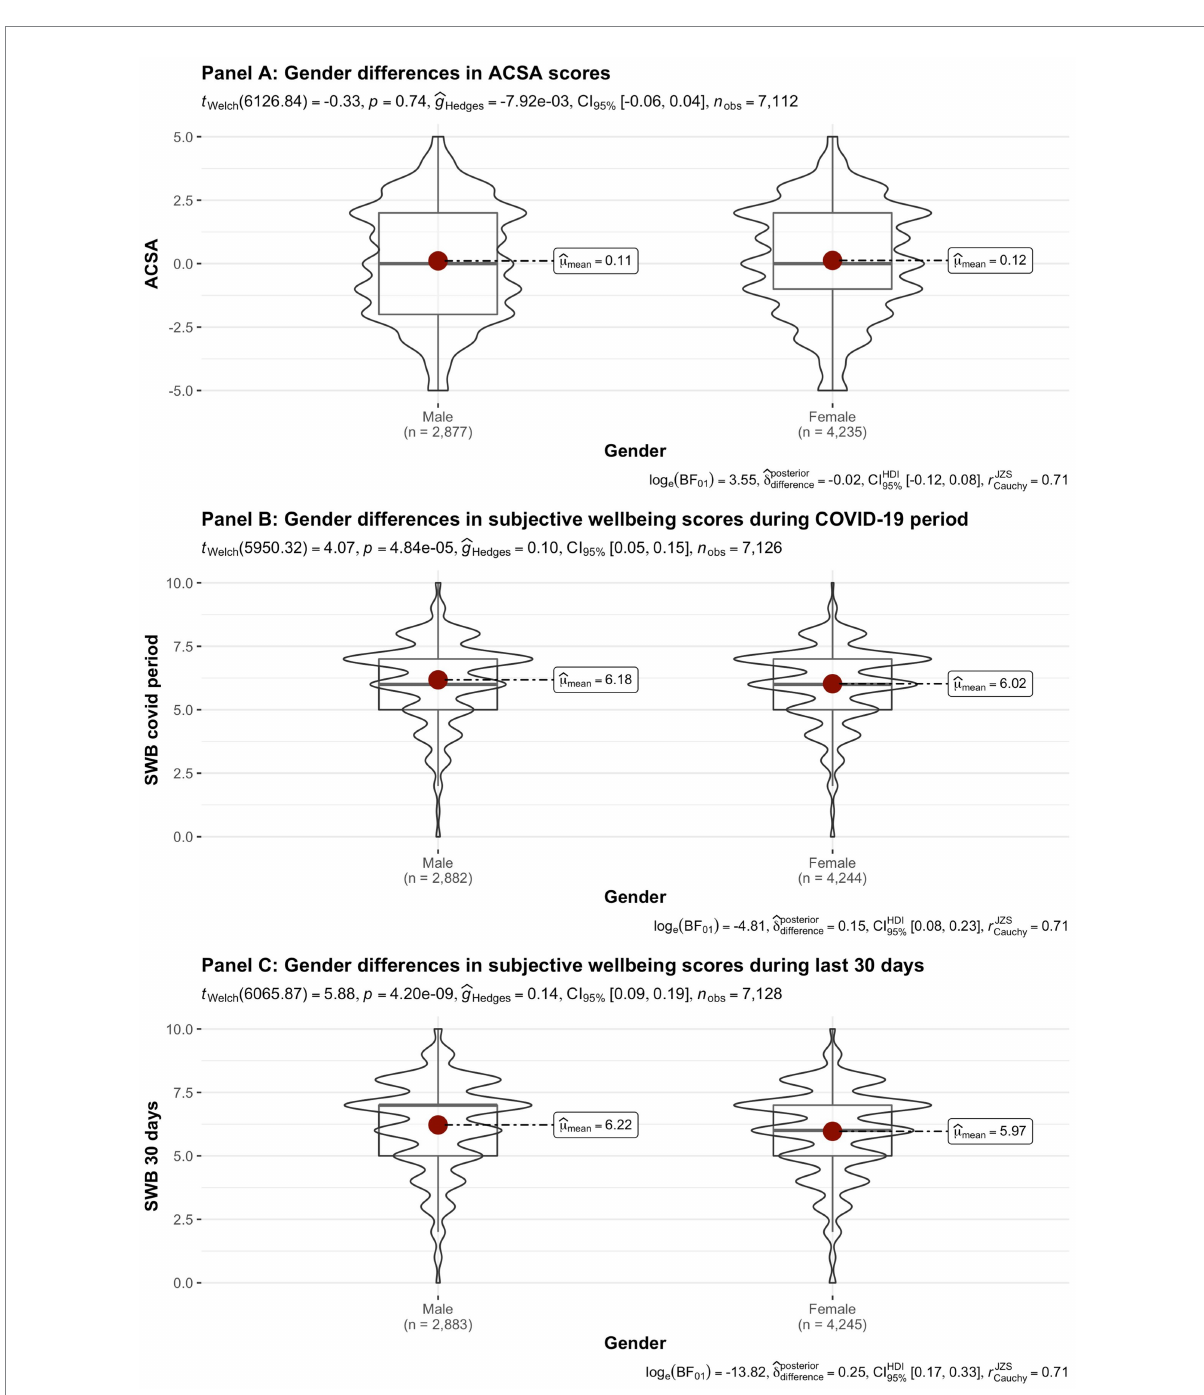
FIGURE 2 Mean Anamnestic Comparative Self-Assessment (ACSA; during the last 2 weeks, on a − 5 to +5 scale) and subjective wellbeing (SWB)-scores (during the COVID-19 period, and during the past 30 days, both on a 0–10 scale) comparing student groups during COVID-19 in terms of